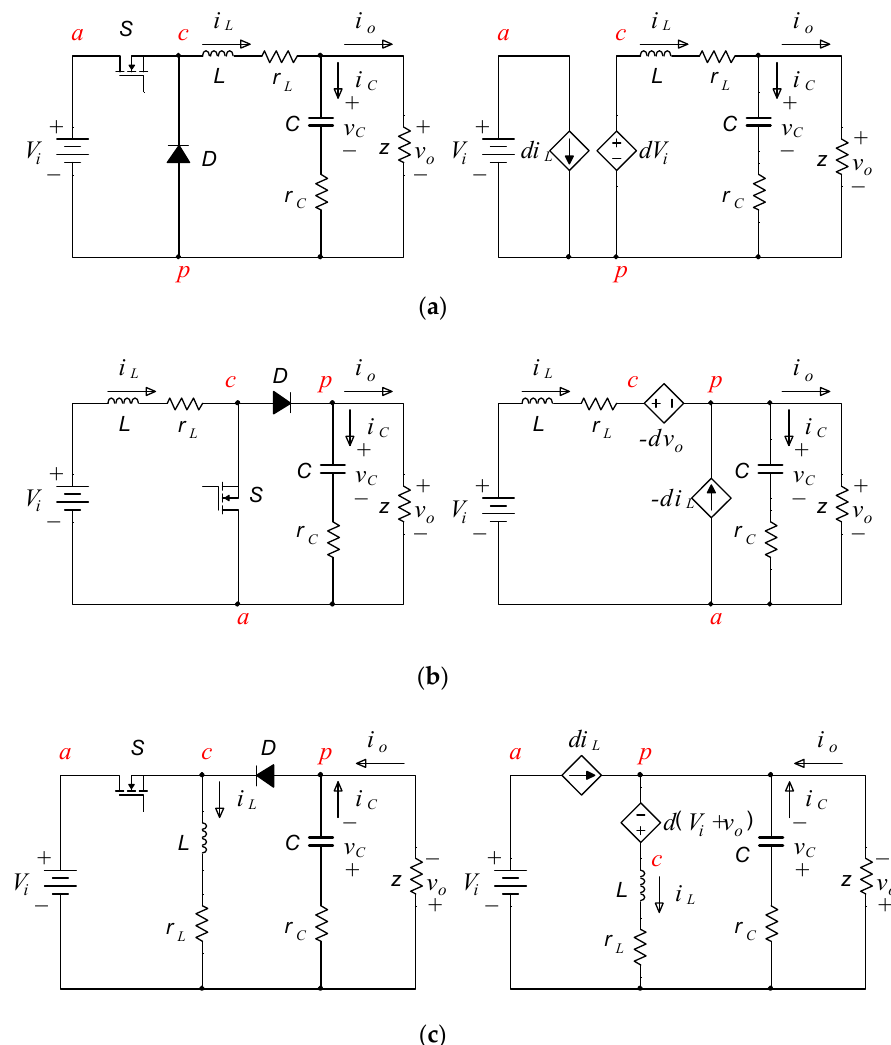
Figure 2. Main circuits and large-signal averaged models of DC/DC converters in the continuous conduction mode (CCM): ( a ) buck converter; ( b ) boost converter; ( c ) buck–boost converter.